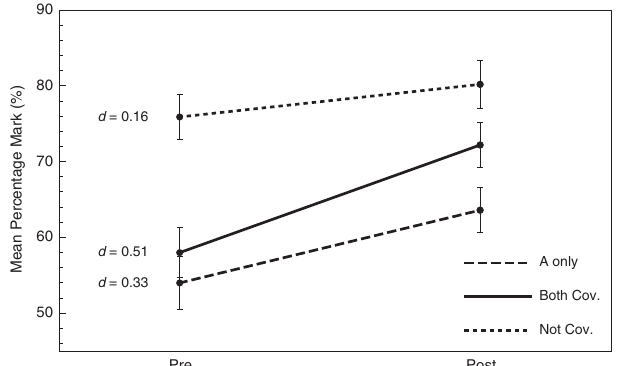
FIG. 3. Mean physics pre- and post-test scores for all 81 students, for each level. A Only (dashed line) refers to the questions that were A Level difficulty (questions 2, 5, 6, and 8). Both Cov. (solid line) refers to the questions that were both GCSE and A Level difficulty, and were covered (questions 1, 4, 7, and 10), while Not Cov. (dotted line) refers to those that were not covered at all (questions 3 and 9). The error bars represent the standard error of the mean. 11 data points, each data point corresponds to a question on the test, and its value is the number of students that